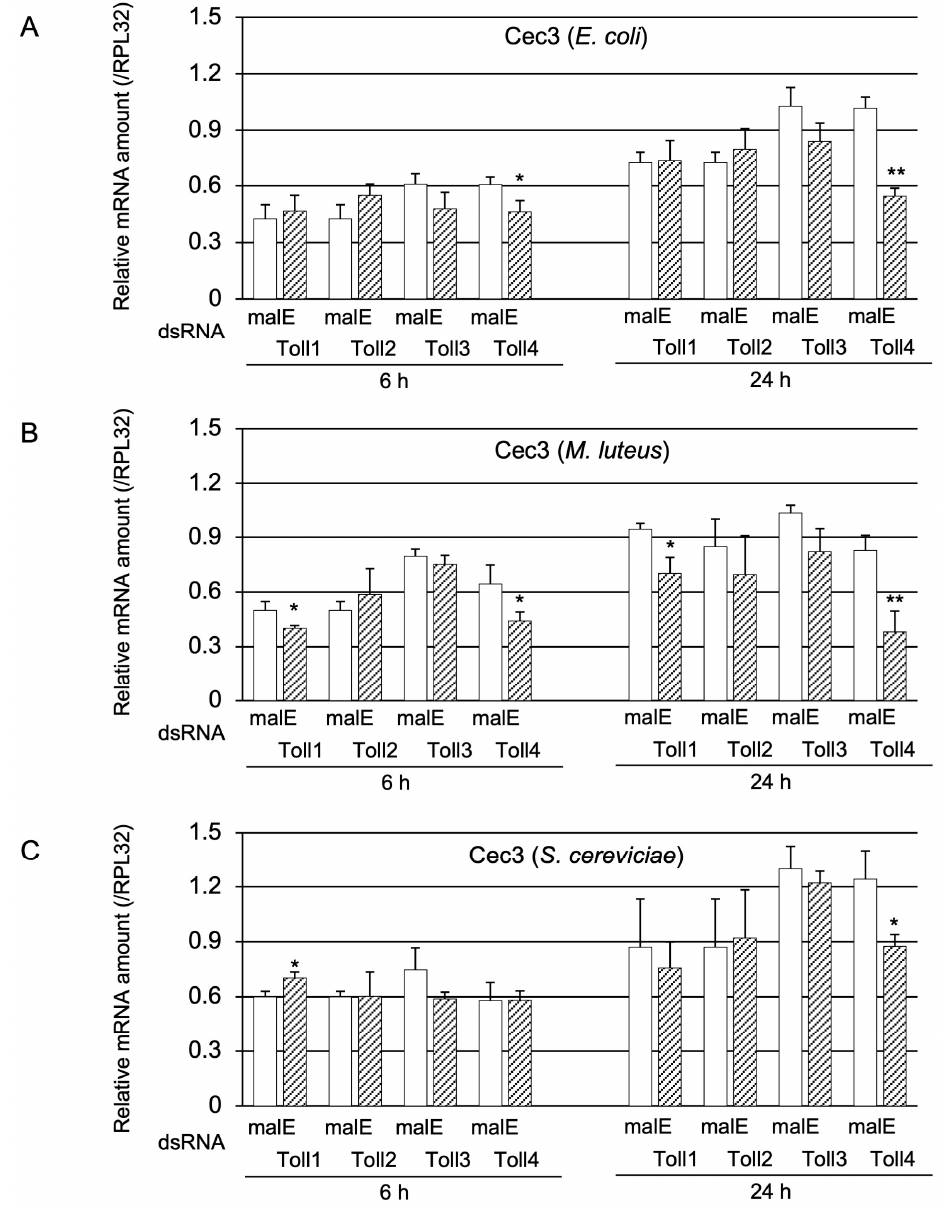
Figure 4. Effect of Toll gene knockdown on Cec3 induction. mRNA level of Cec3 in pupae treated with either malE dsRNA (open bars, control) or Toll1, Toll2, Toll3, or Toll4 dsRNA (shaded bars) after challenge with either Ec ( A ), Ml ( B ), or Sc ( C ). The methods of sample preparation and mRNA level measurement were the same as those described in Figure 3. Experiments with three animals were independently repeated three times, and each column represents the mean ± S.D. Asterisks and double-asterisks indicate p < 0.05 and p < 0.01 compared to Uc samples, respectively, according to Student’s t